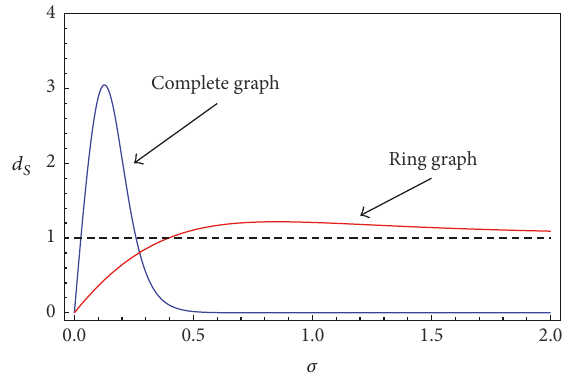
Figure 2: Spectral dimensions for the Ring graph (geometric phase) and the Complete graph (nongeometric phase) with 𝑁 = 20